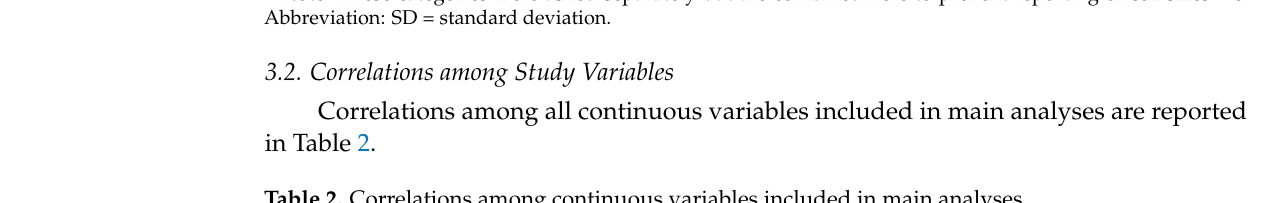
Table 2. Correlations among continuous variables included in main